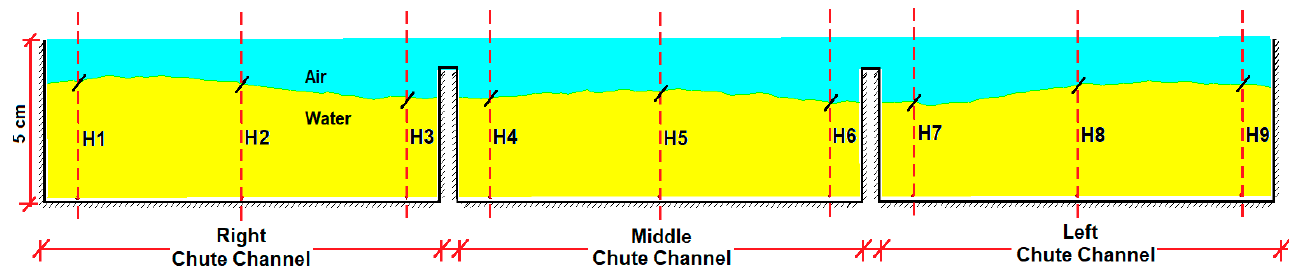
Figure 22. CFD water depth contours for Cross-section 2.